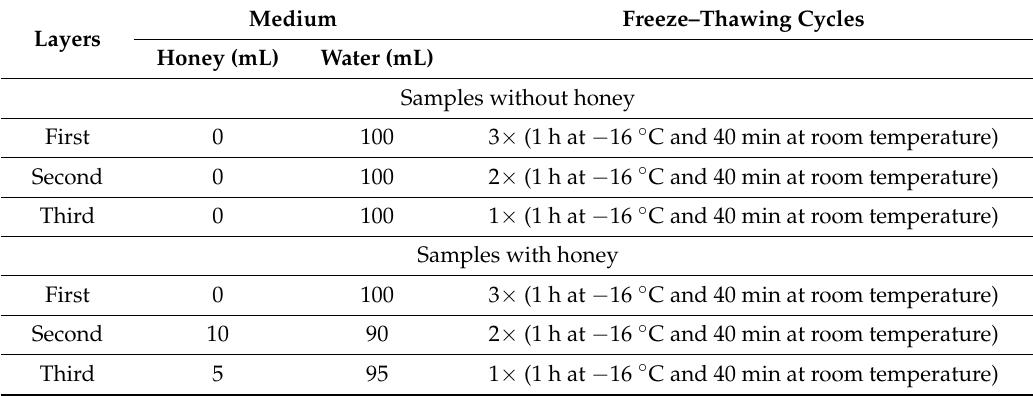
Table 1. Layer-wise composition of media (honey and water) and freeze–thaw cycle